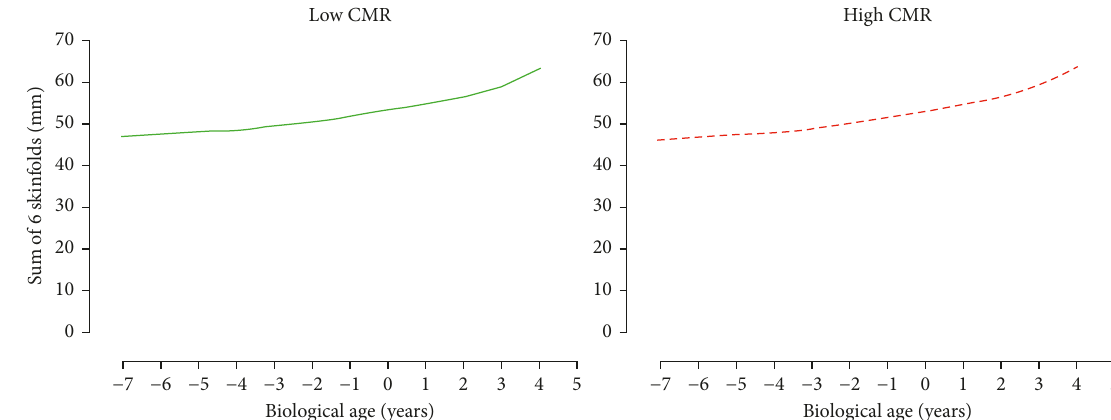
Figure 3: Predicted adolescent sum of six skinfolds growth trajectories for individuals categorized as having low and high cardiometabolic risk (CMR) in adulthood. Predicted models adjusted for biological age, height, and